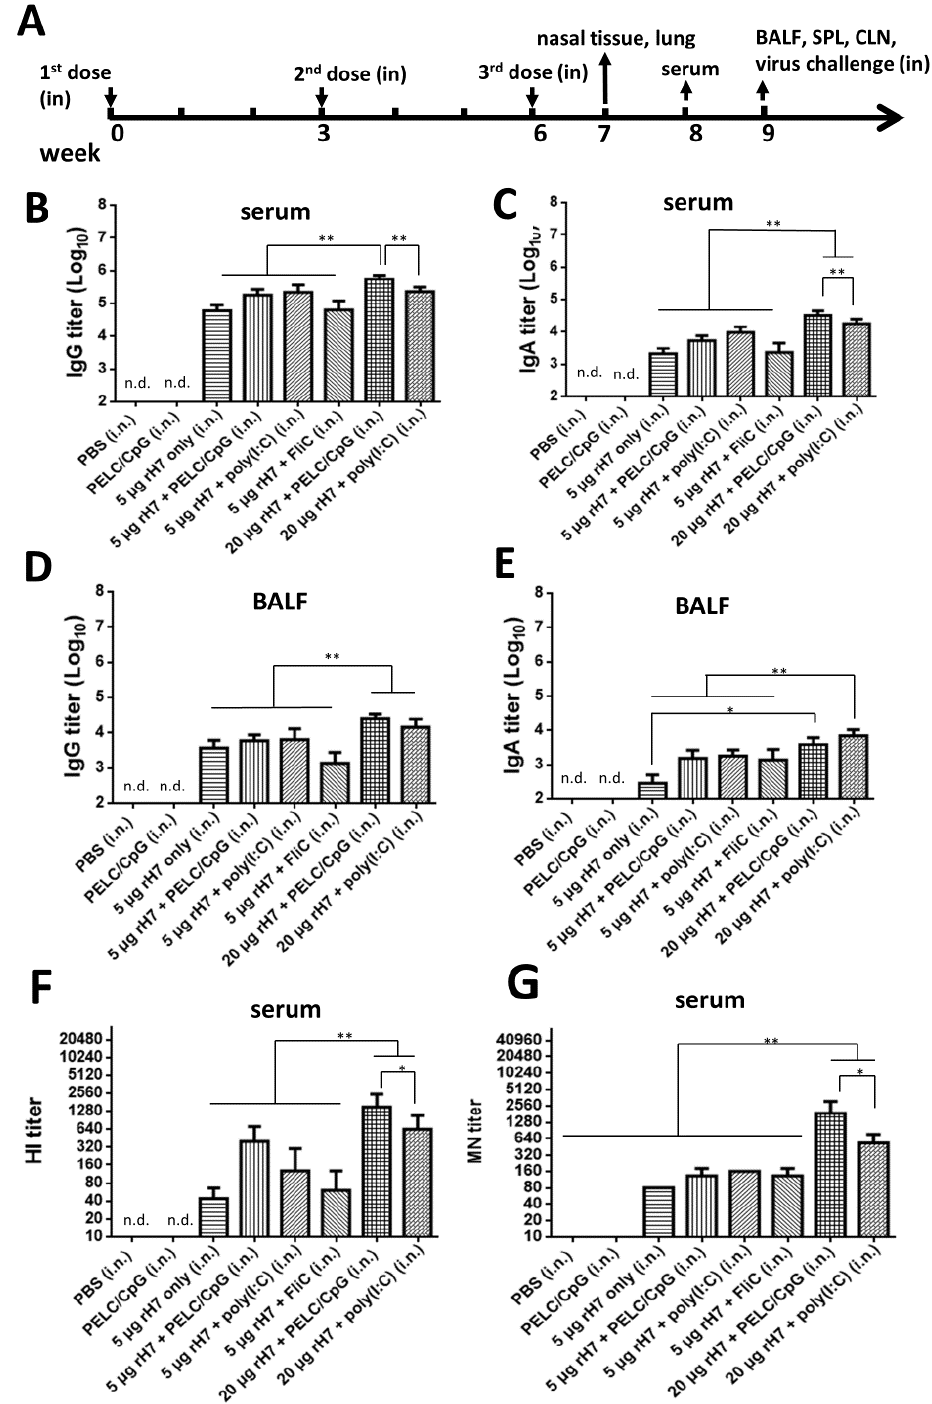
Figure 1. Antibody responses in sera and BALFs elicited by intranasal immunizations with rH7 proteins formulated in PELC nanoemulsion plus CpG. ( A ) Groups of mice were intranasally immunized with three doses of 5 or 20 µ g rH7 protein formulated with PELC / CpG, poly (I:C), or FliC over a 3-week interval. Serum and BALF samples were collected and analyzed using ELISA to measure ( B , D ) H7-specific IgG and ( C , E ) IgA antibody titers. Hemagglutination (HA) inhibition and neutralization antibody titers in sera were respectively determined using ( F ) hemagglutination inhibition (HI) and ( G ) microneutralization (MN) assays. n.d. (not detected). Statistical analysis consisted of one-way ANOVA. *, p < 0.05; **, p <